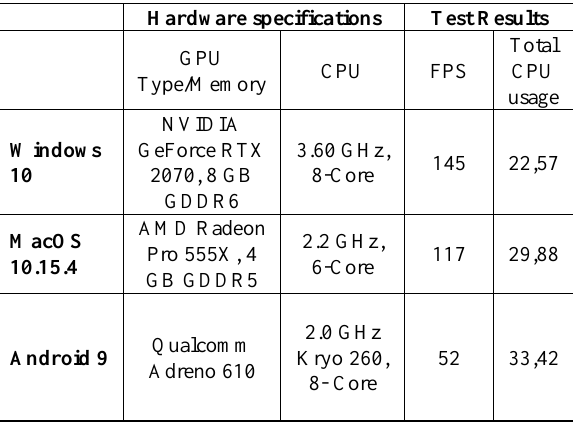
Table 1. Experimental setup and part of the performance results for each operating system and device's hardware